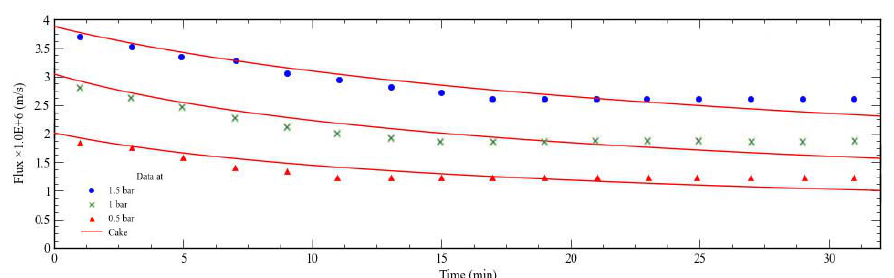
Fig. 6: Flux vs. time data for skim milk through Pellicon cassette ultrafiltration membrane module compared to the cake formation model at different TMPs.